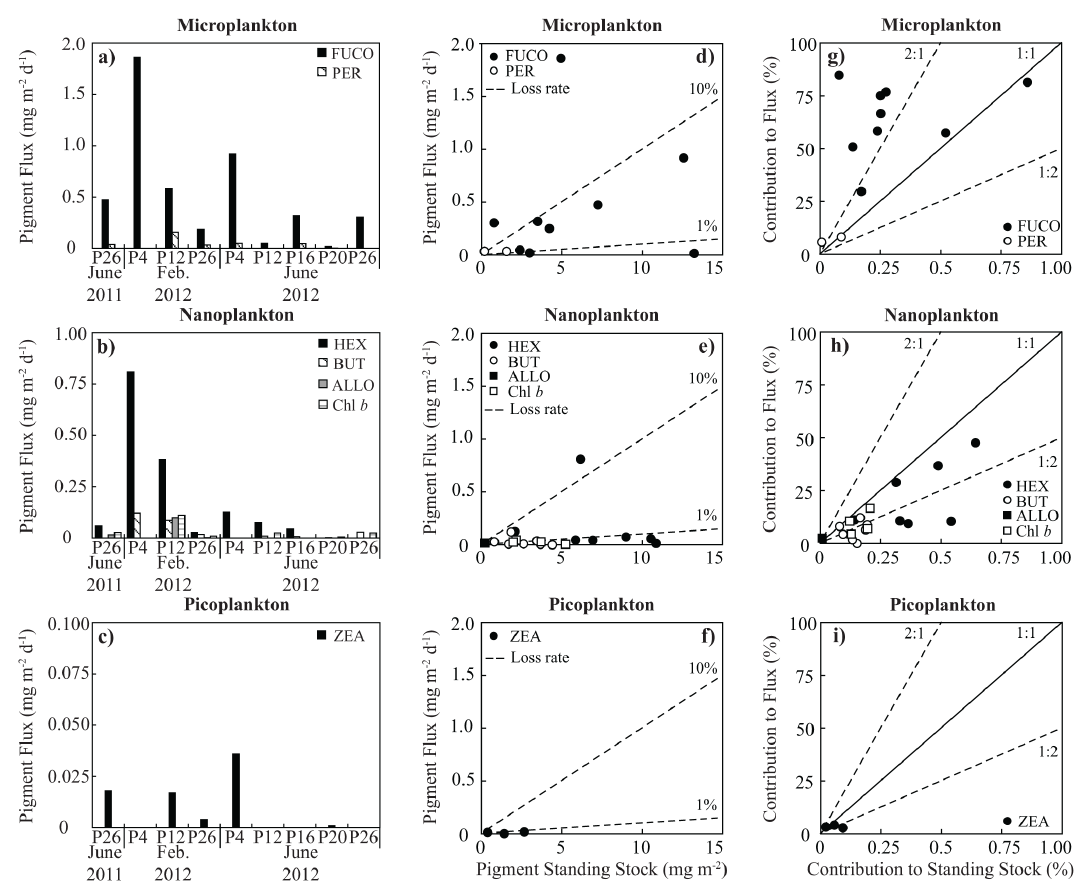
Figure 12. (a–c) 234 Th-derived indicator pigment fluxes determined using the pigment / 234 Th ratio on > 53µm particles plotted for micro-, nano-, and picoplankton pigments. (d–f) Indicator pigment standing stocks plotted against indicator pigment fluxes for micro-, nano-, and picoplankton pigments. The slopes of the dashed lines indicate pigment loss rates. (g–i) The contribution to total pigment standing stocks plotted against the contribution to total pigment flux for micro-, nano-, and picoplankton pigments. Data points above the 1 : 1 line indicate preferential export by direct sinking, and points below the 1 : 1 line indicate disproportionately low export by direct sinking relative to biomass